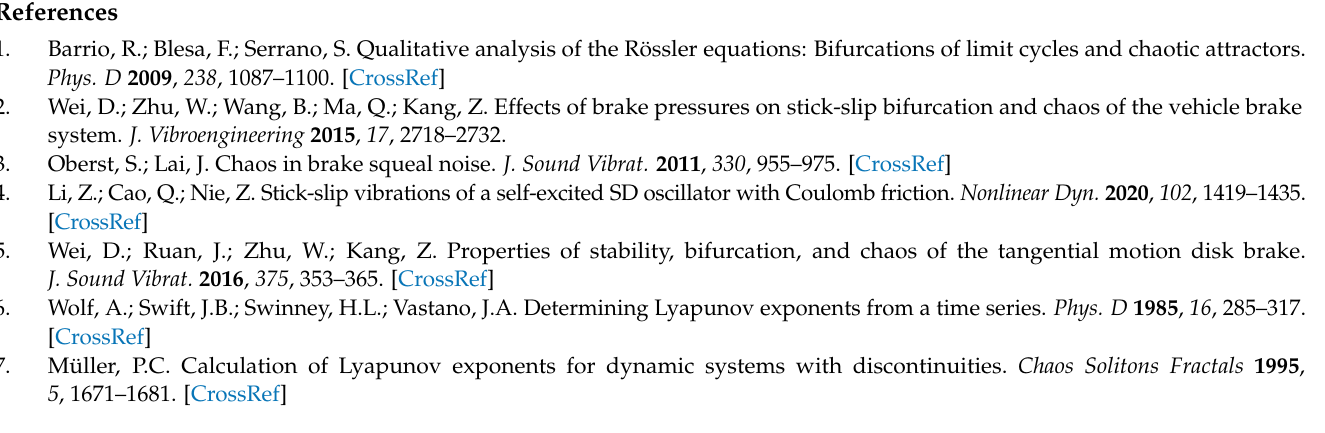
Figure 11. Unthresholded recurrence plot by ( a ) chaos and ( b ) non-chaos (chaos: [1 0], non-chaos: [0 1]).